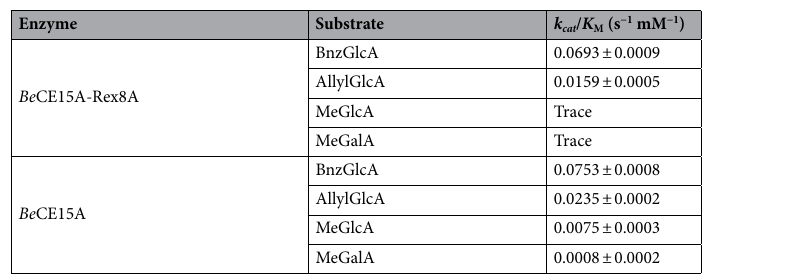
Table 1. Activity of Be CE15-Rex8A and Be CE15A on GE model substrates. “Trace” stands for trace activity detected for 0.02 µM min −1 mg −1 protein. The reactions were not saturable up to 40 mM and linear regression was used to calculate the k cat / K M values using GraphPad Prism 8. The results are based on triplicate measurements and presented with standard errors of the mean. The Be CE15A variants F231R and F231Y were also assayed, but no activity could be